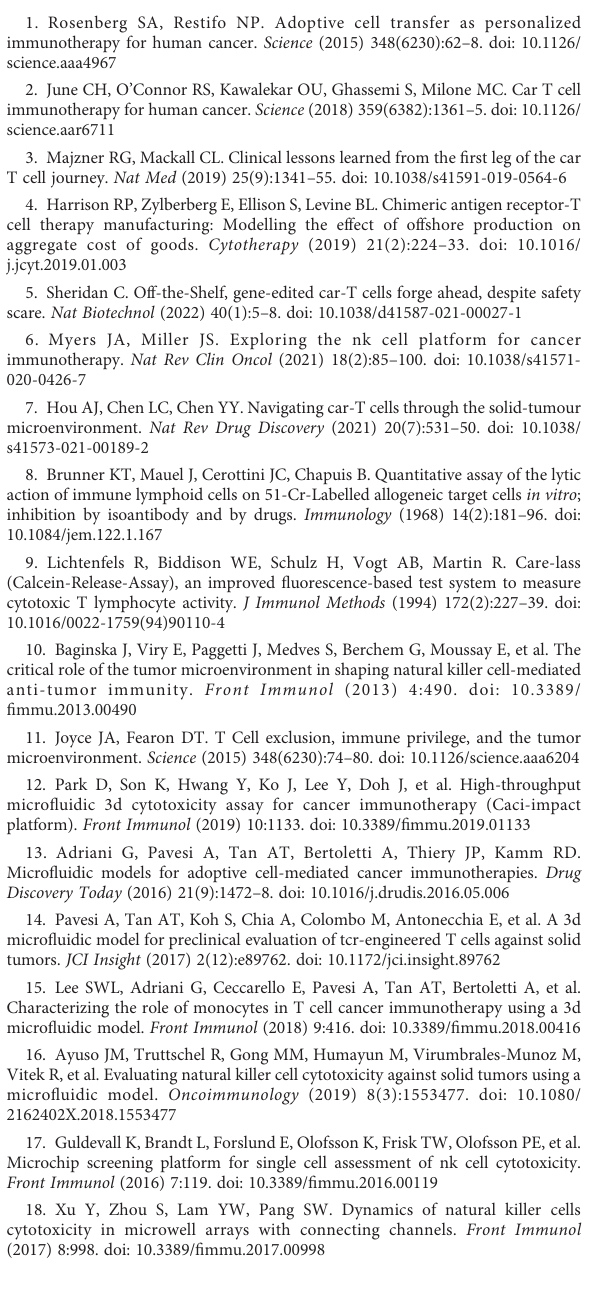
SUPPLEMENTARY VIDEO S3 A representative movie showing an OT-1 cell (yellow boundary) interacting with a B16F10-OVA cell (blue labeled with white boundary) in a BSA-coated microwell. Scale bars: 10 m m. Time stamp: hh:mm. SUPPLEMENTARY VIDEO S4 A representative movie showing an OT-1 cell (yellow boundary) interacting with a B16F10-OVA cell (blue labeled with white boundary) in a FN-coated microwell. Scale bars: 10 m m. Time stamp: